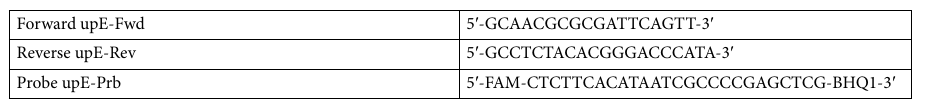
Table 2. Primers used to analyze MERS-CoV replication in Bactrian camel and llama AEC cultures.